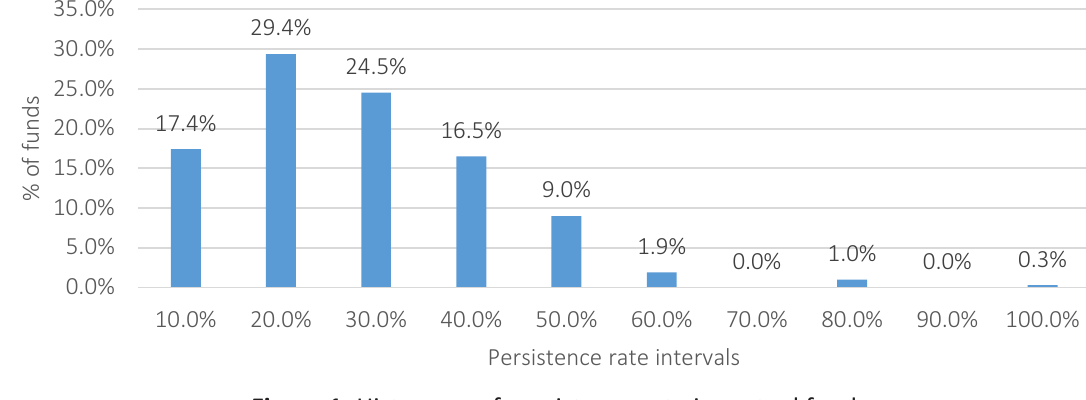
Figure 1. Histogram of persistence rate in mutual